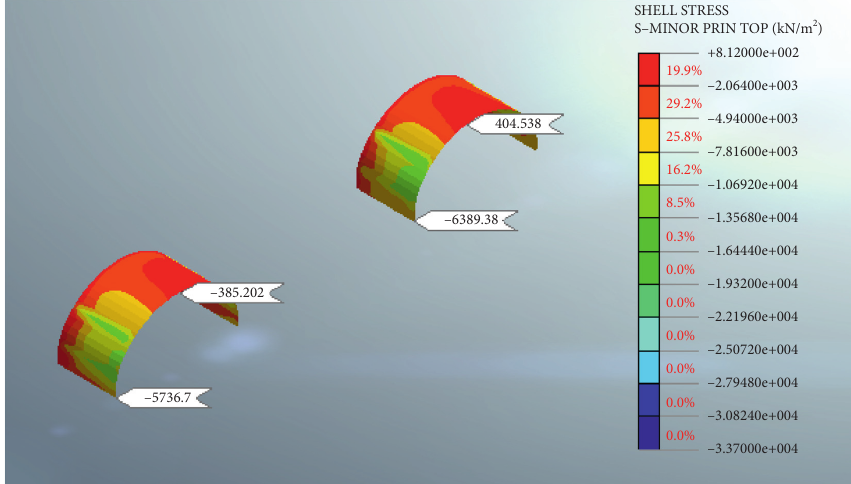
Figure 29: Initial lining stress distribution in three-step method.